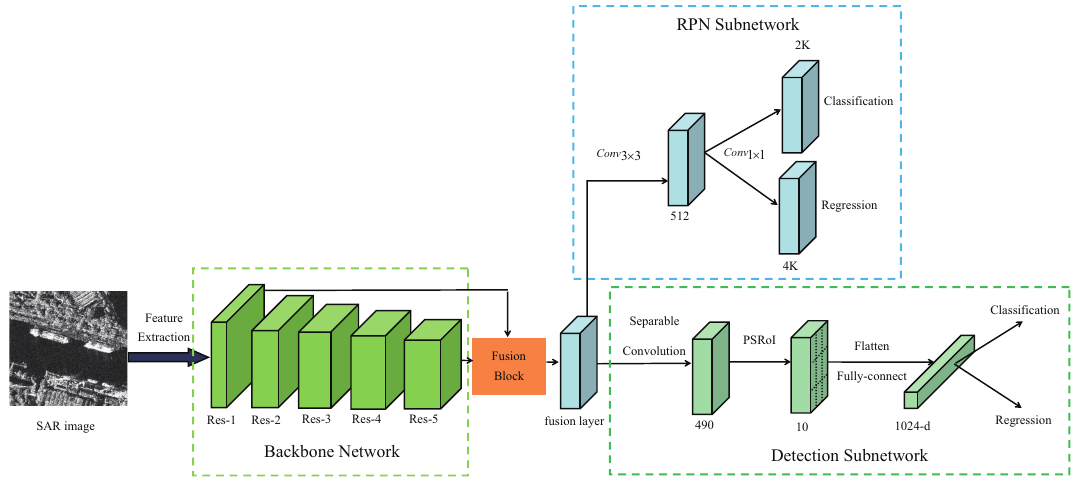
Figure 1. The architecture of proposed